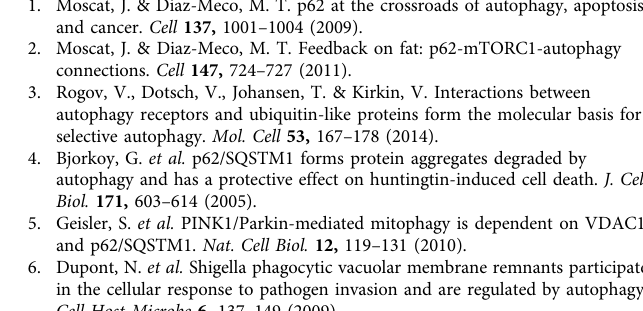
Supplementary Table 8. Potential hydrogen bonds and van der Waals contacts were analysed using the program LIGPLOT 65 . Molecular graphics were prepared using